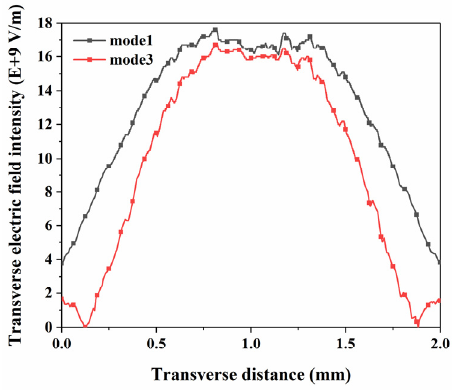
Figure 7. ( a ) ω – β diagram and ( b ) normalized phase-velocity characteristics with different s2 (in mm).